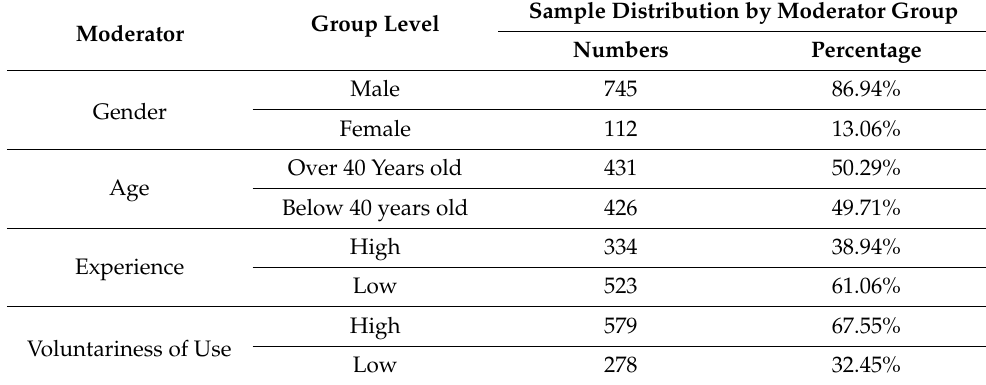
Table 5. Sample distribution across four moderator